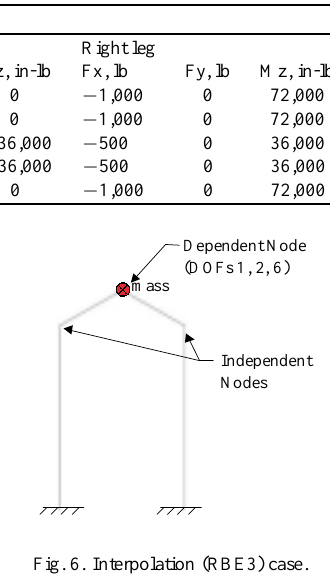
Fig. 6. Interpolation (RBE3) case.